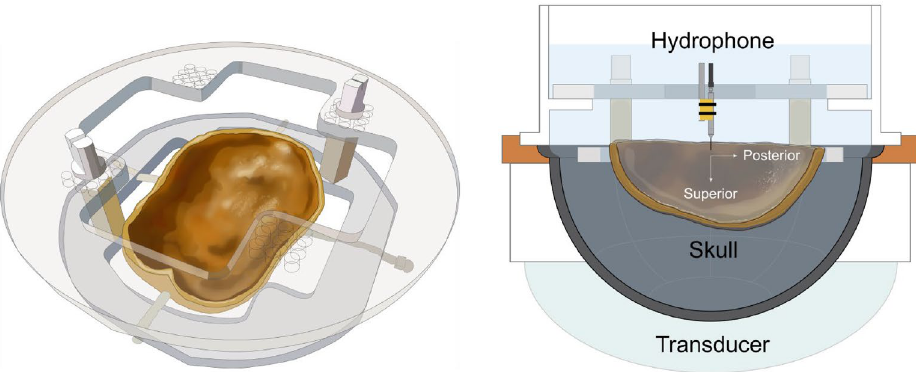
Figure 3. Experimental setup used in this study. Three ex vivo skulls were used for experimentation. Each of the three skulls was fixed to a head frame to ensure consistent positioning. The head frame was secured in an